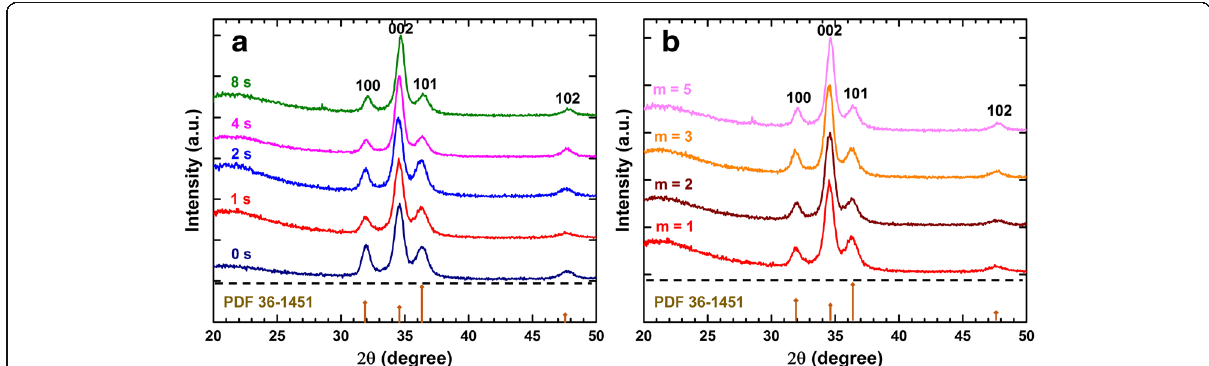
Fig. 2 XRD patterns of ZnO films grown by the supercycled ALD process using a different O 2 plasma times with fixed thermal cycle ( m = 1) and b different thermal cycles with fixed O 2 plasma time ( t 3 = 1 s)